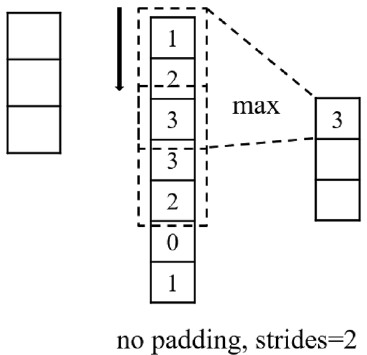
Figure 3. This is a schematic diagram of one-dimensional